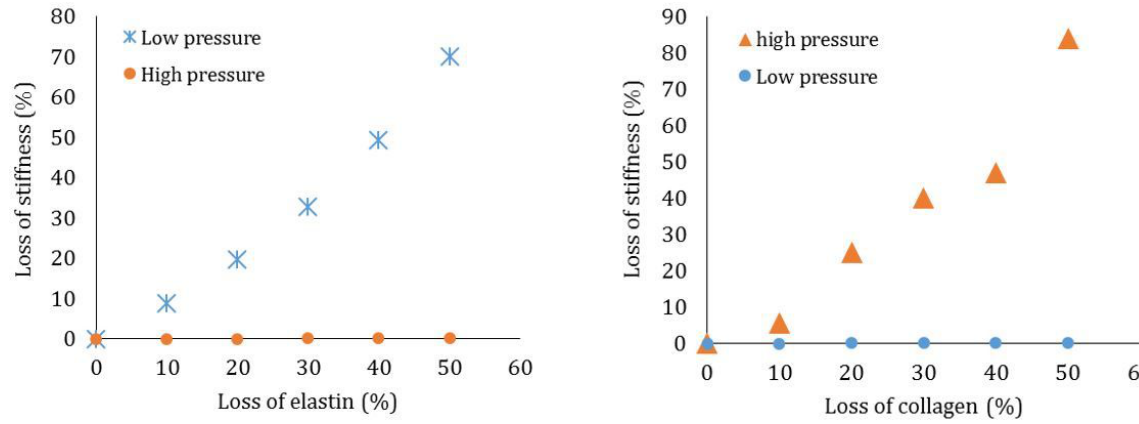
Figure 6: The influence of Collagen disruption and elastin fragmentation on the LU stiffness